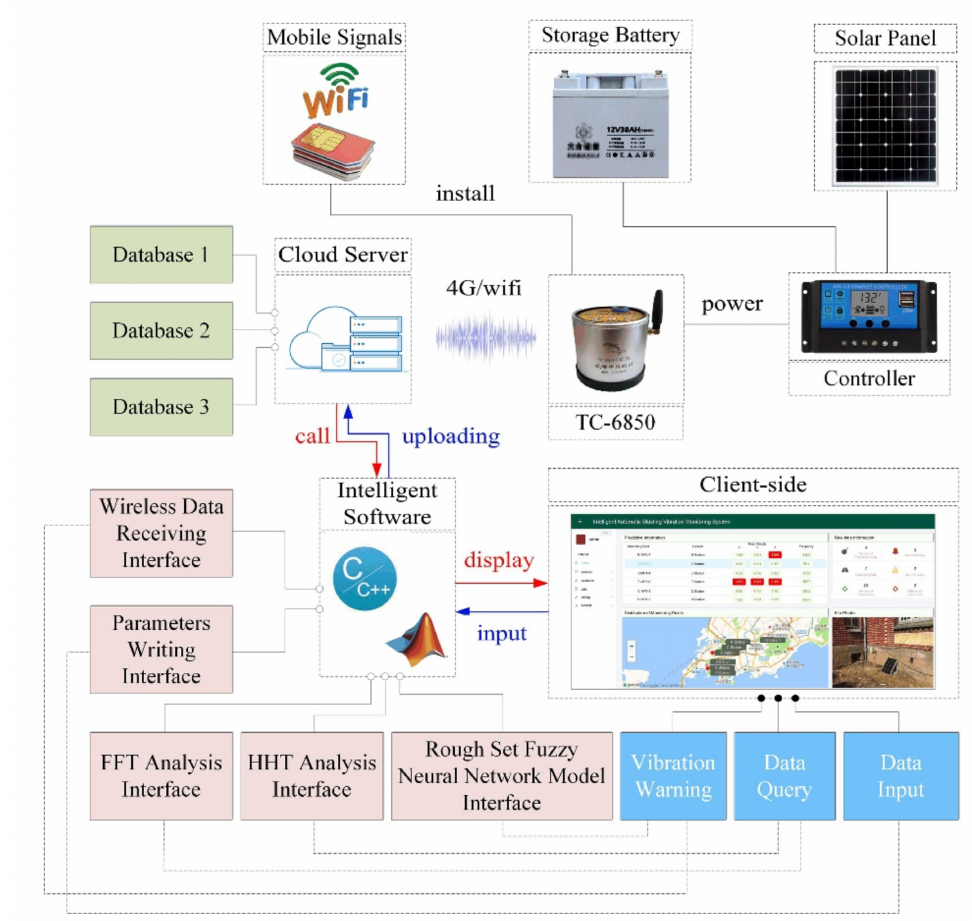
Figure 4. Schematic diagram of the intelligent automatic blasting vibration monitoring system.